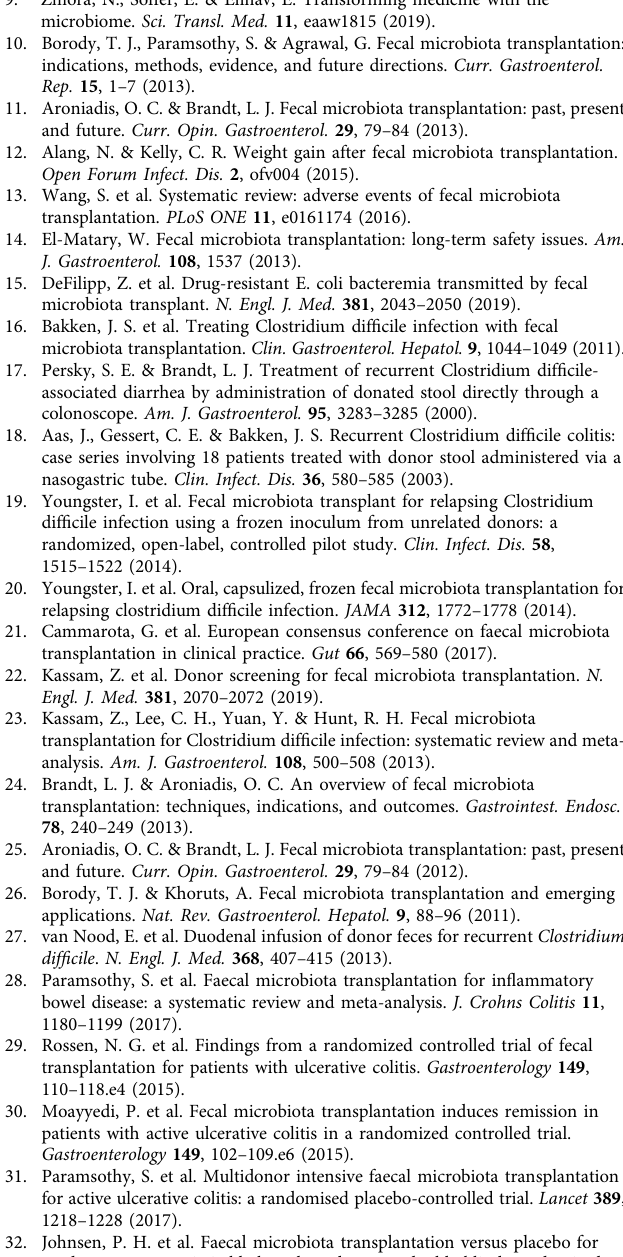
Fig. 9 Personalized probiotic cocktails effectively decolonize C. dif fi cile . a An ecological network involving the GnotoComplex micro fl ora (a mixture of human commensal bacterial type strains) and C. dif fi cile was inferred from mouse data 65 . Node C represents C. dif fi cile . The edge width and node size indicate the interspecies interaction strength and the intrinsic growth rate, respectively. Red (or blue) edges indicate the direct promotion (or inhibition), respectively. b A disrupted microbiota due to a hypothetic antibiotic administration. c The restored microbiota due to the administration of a particular probiotic cocktail R global . d The trajectory of C. dif fi cile abundance over three different time windows: (1) the initial healthy microbiota, (2) the disrupted microbiota, and (3) the microbiota post probiotic administration. In the third time window, we compare the performance of various probiotic cocktails in terms of their ability to decolonize C. dif fi cile . Those cocktails were designed by considering direct inhibitors only ( R d ), the global ecological network ( R global ), the n -step ego-networks of C. dif fi cile with n = 1, 2, 3 ( R ego-1 , R ego-2 , and R ego-3 ), and randomly chosen subsets of R global ( R 1 , R 2 , and R 3 ). R near-optimal is obtained by excluding species-12 (i.e., K. oxytoca , which is an opportunistic pathogen) from R global . Note that R ego-1 is not necessarily always the same as R R – g We start from the same initial microbiota as shown in panel d because ego-1 needs to consider the net impact among neighbors of the focal species. e ( a ). But another hypothetic antibiotic administration can lead to a different disrupted microbiota ( f ), which can be restored through probiotic administration ( g ). h Performance of different probiotic cocktails in decolonizing C. dif fi